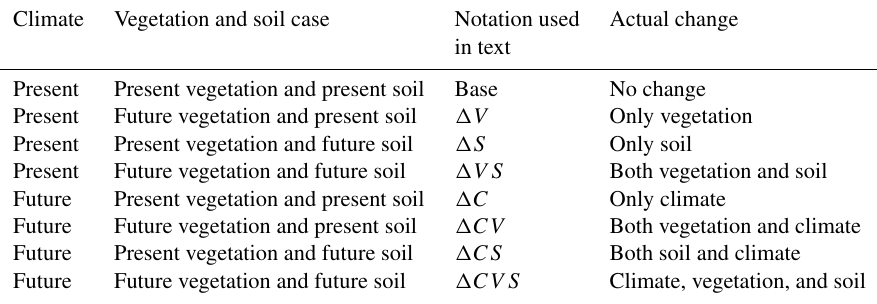
Table 2. Description of the eight cases of change in climate, vegetation, and